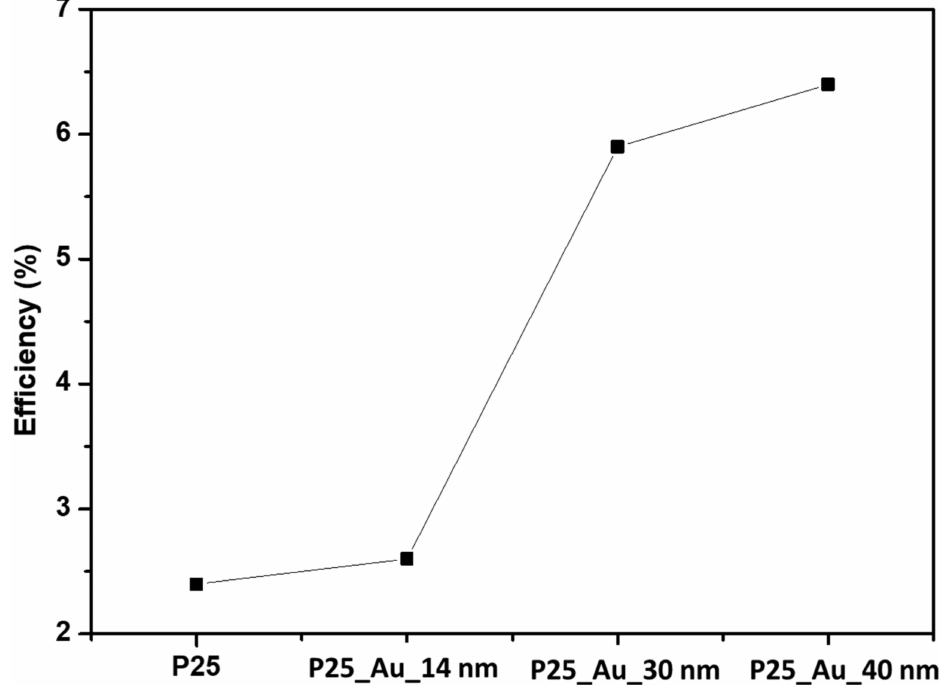
Figure 9. Solar cell efficiency curve comparison of TiO 2 and different sizes of gold